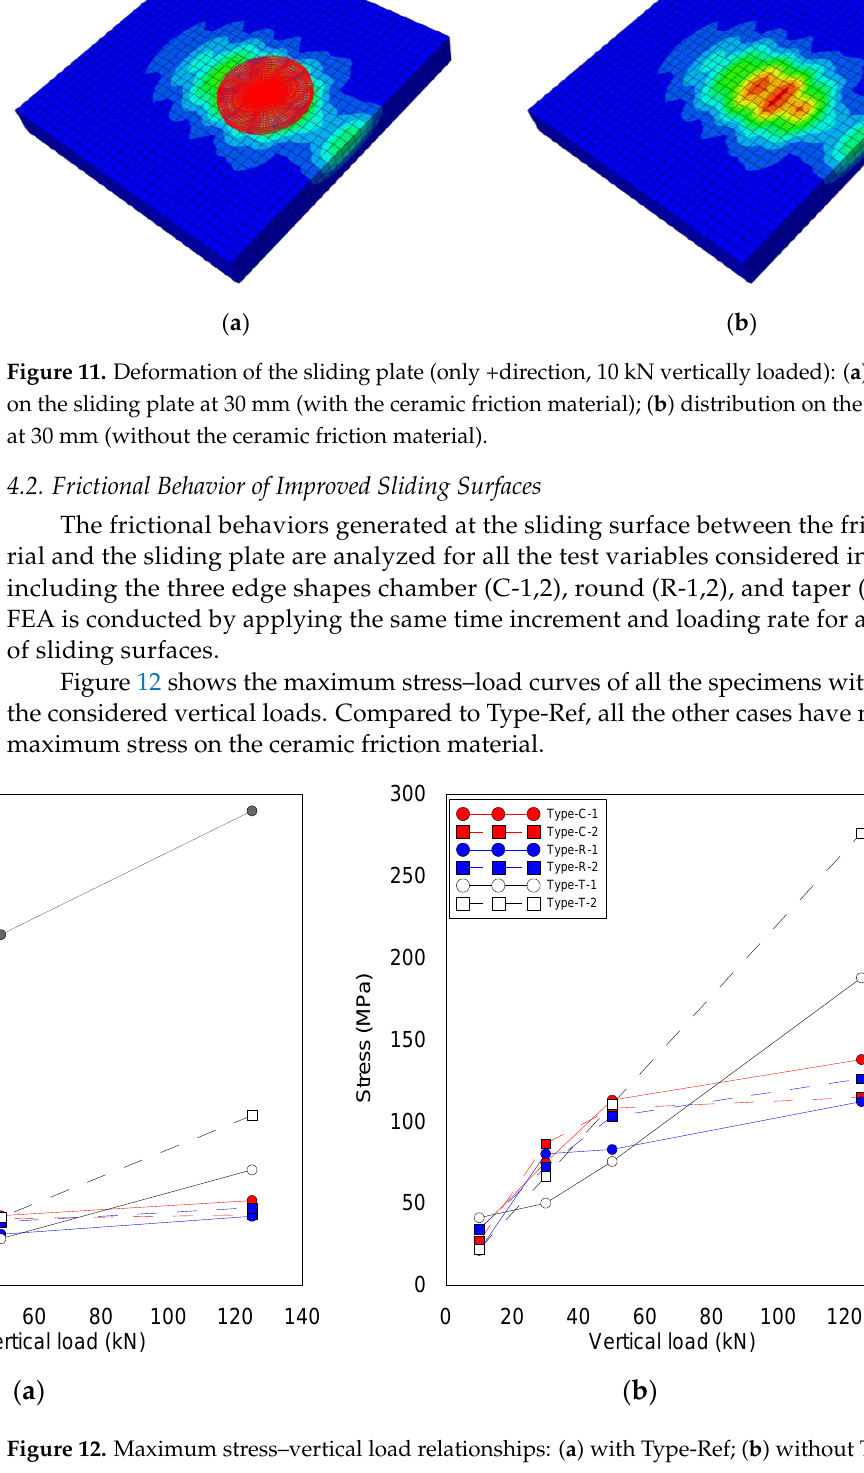
Figure 10. Horizontal load – slip relationships (only +direction, 10 kN vertically loaded).